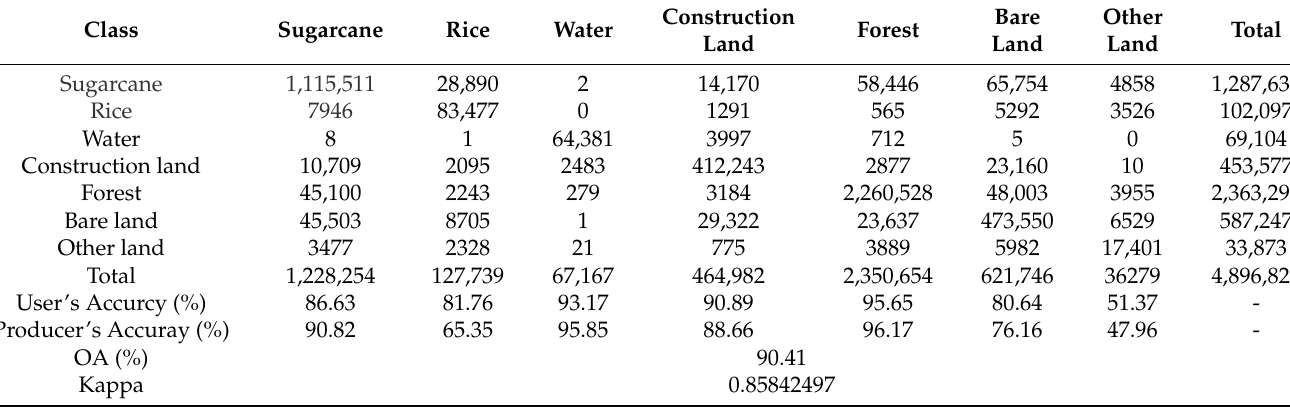
Table 10. Accuracy evaluation table of classification results in